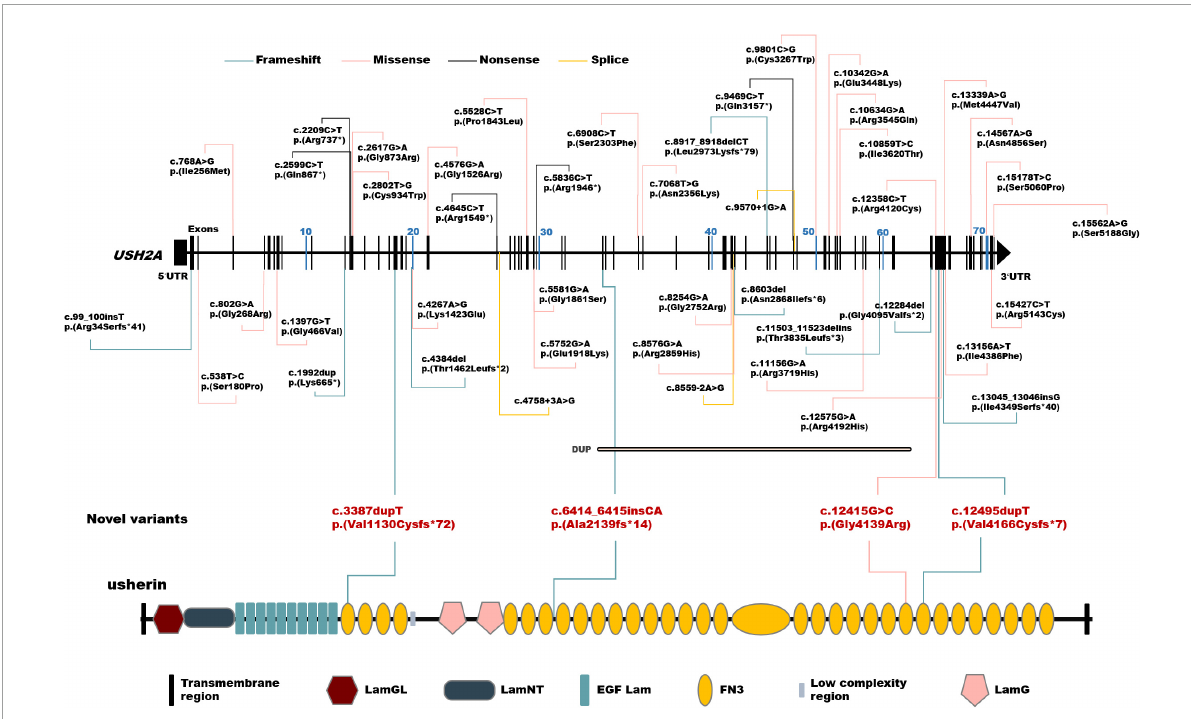
FIGURE2 Schematic distribution of the USH2A variants identified in this study. Upper, schematic presentation of the USH2A gene and the distribution of variants identified in our inherited retinal dystrophy (IRD) cohort. Novel variants are highlighted in red. Lower, usherin domains encoded by USH2A . LamGL, laminin G-like domain; LamNT, laminin N-terminal domain; EGF_Lam, laminin-type epidermal growth factor-like domain; FN3, fibronectin type III domain; LamG, laminin G